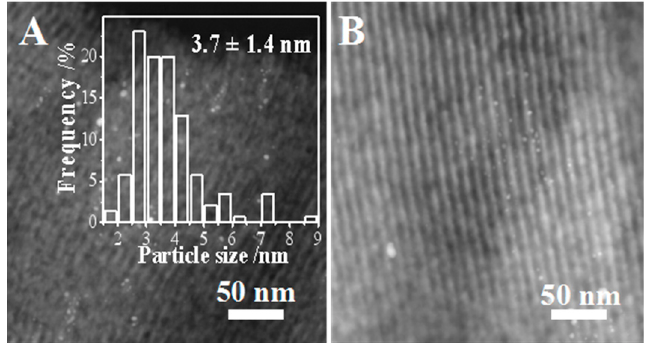
Figure 8. HRTEM images ( A , B ) of the 1%Pt-SBA-15 pH = 6C catalyst after 90 h reaction. The inset in image ( A ) is the histogram of the Pt NP frequency distribution.